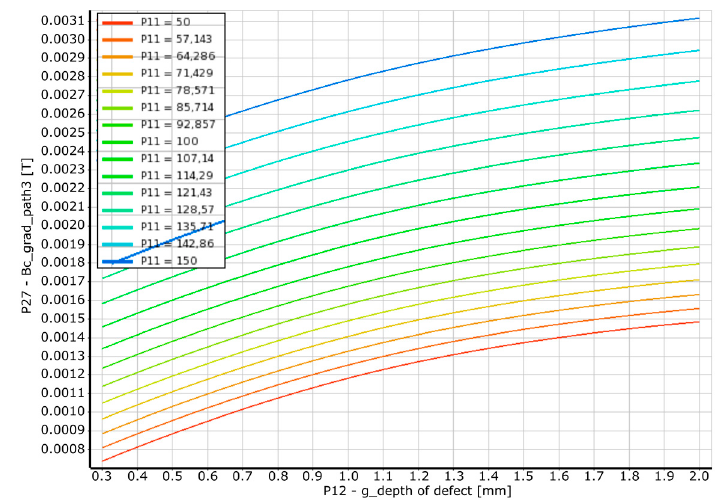
Figure 13. Gradient B c from detection path versus continuous change of defect width and step change of defect depth.